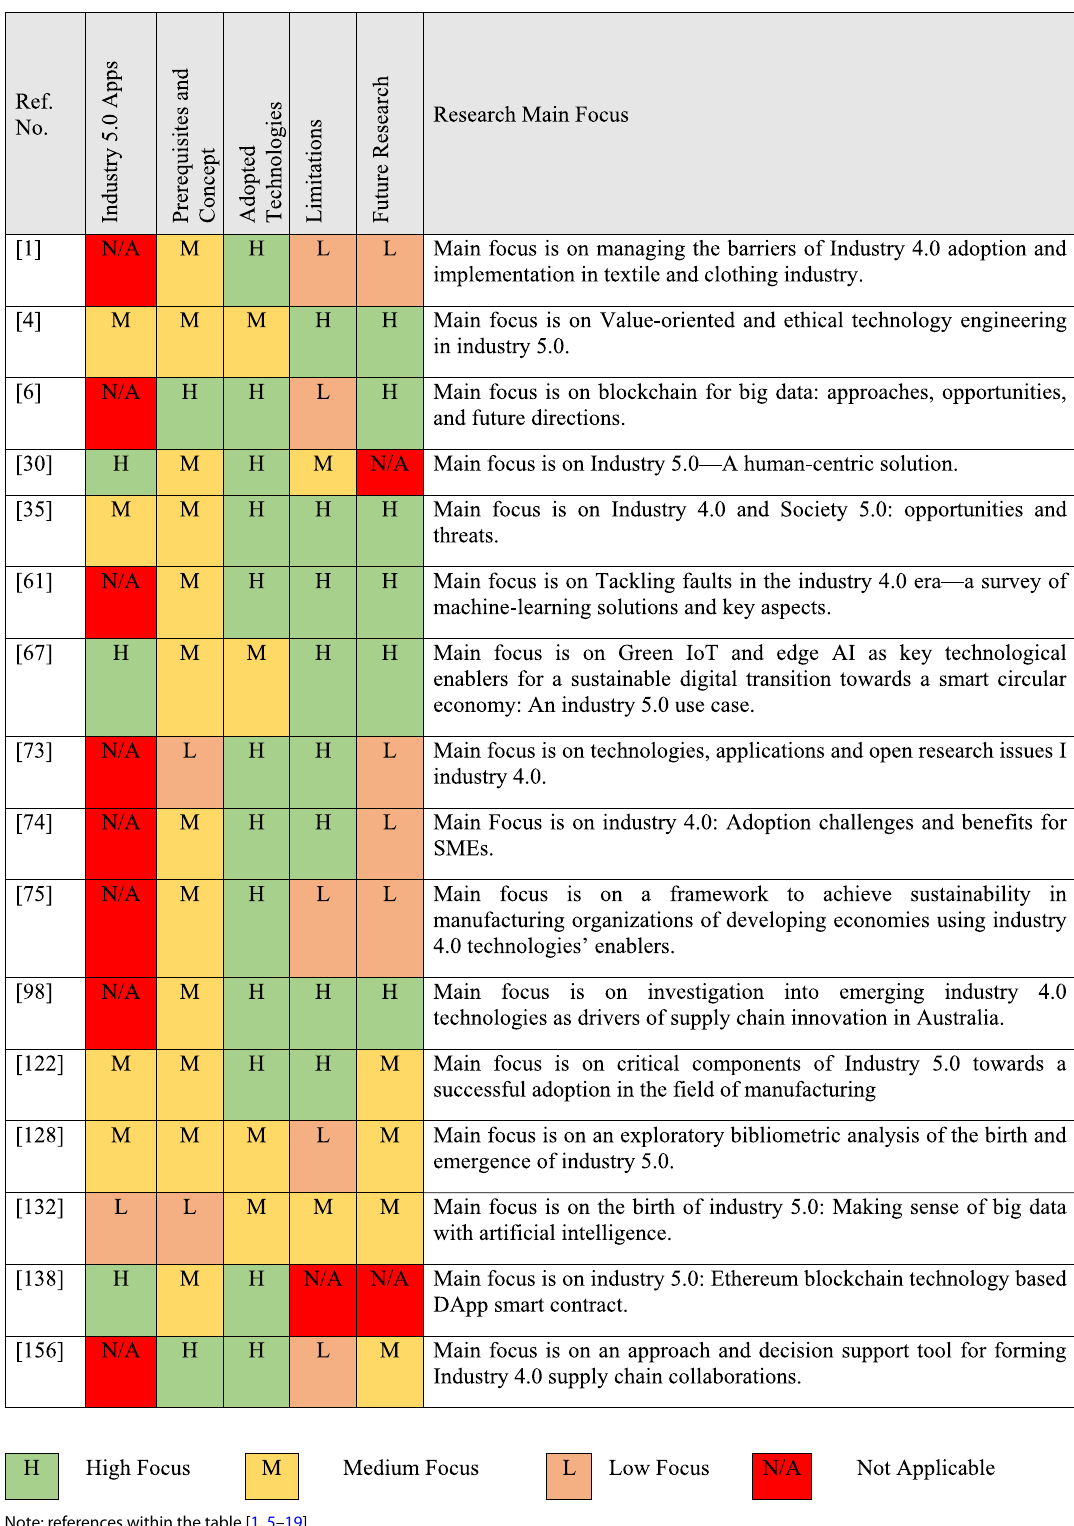
Table 1 Summary table of most relevant